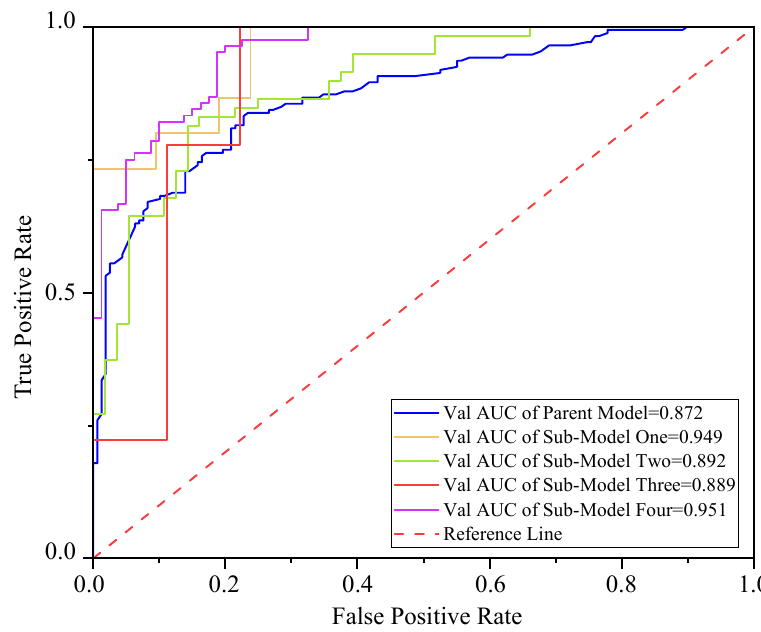
Figure 10. Validation AUC values of different models. Table 6. Top five important factors in different sub-zones.